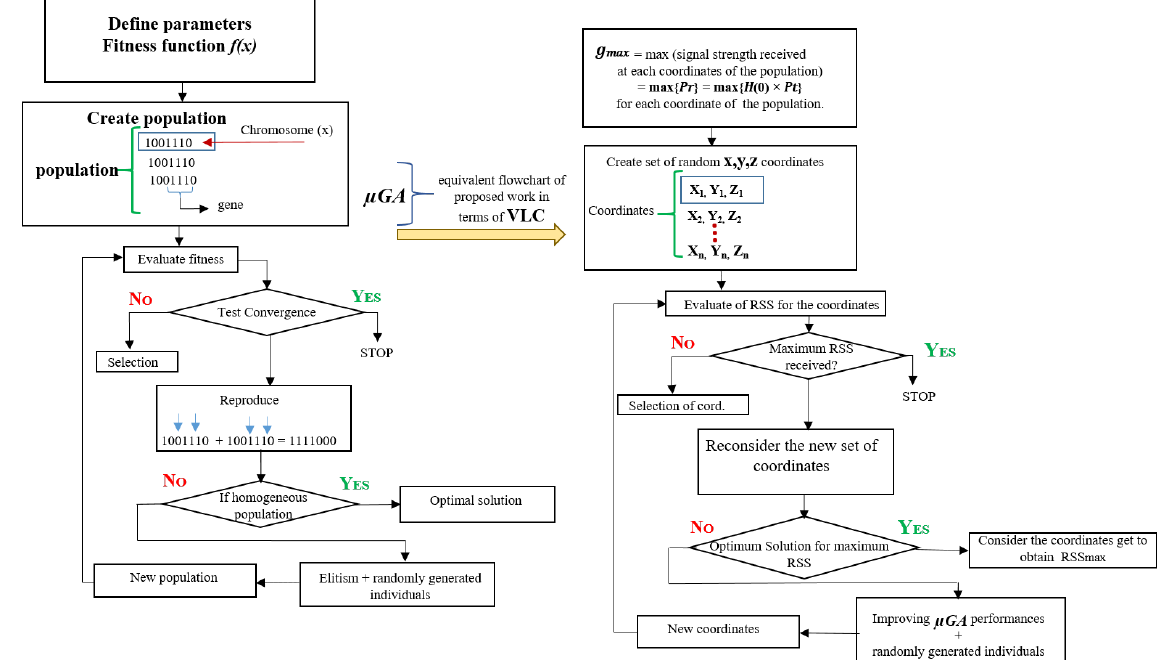
Figure 7. Algorithm of the proposed µ GA-based V-VLC